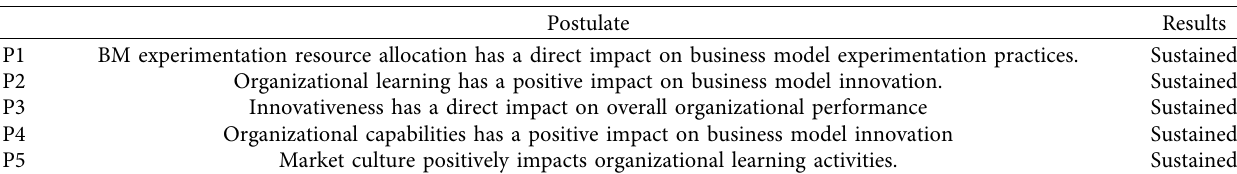
Table 3: Postulate and